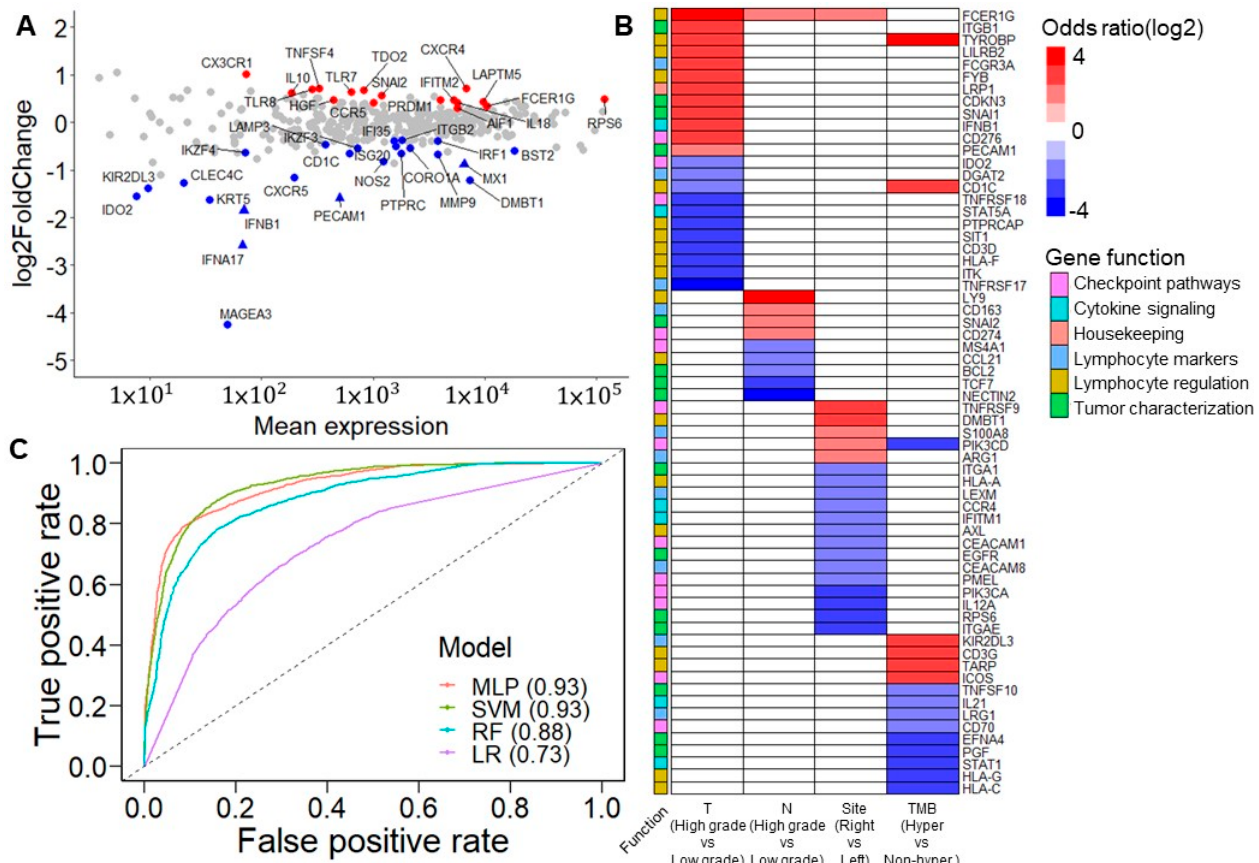
Figure 3. Prognostic immune response eGenes and tumor characteristics. ( A ) M (log ratio)-A (mean average) plot for the differentially expressed genes (DEGs) between patients with/without recurrence. Red points indicate the upregulated DEGs in patients with recurrence. Blue points indicate downregulated DEGs in patients with recurrence. Triangles indicate the significant DEGs after FDR correction. Most of the downregulated DEGs, including IFNB1 , MX1 , ISG20 , CXCR5 , BST2 , IFI35 , and IRF1 , are involved in interferon signaling. However, lymphocyte regulators such as CX3CR1 , CXCR4 , TLR8 , TLR7 , CCR5 , IL18 , FCER1G , and LAPTM5 are slightly upregulated in patients with recurrence. ( B ) Association between dichotomized immune response genes and clinical features. The association was derived from Fisher’s exact test. The color scale indicates the odds ratio. Red indicates that a high expression positively impacts tumor invasion, tumor nodal stage, tumor originating from the right side of the colon, and hypermutation status. Blue indicates that high expression negatively impacts these clinical features. White is used when